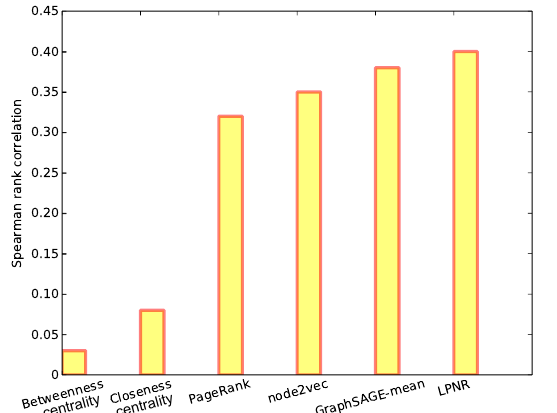
Fig. 2 Node representation evaluation under the node clustering